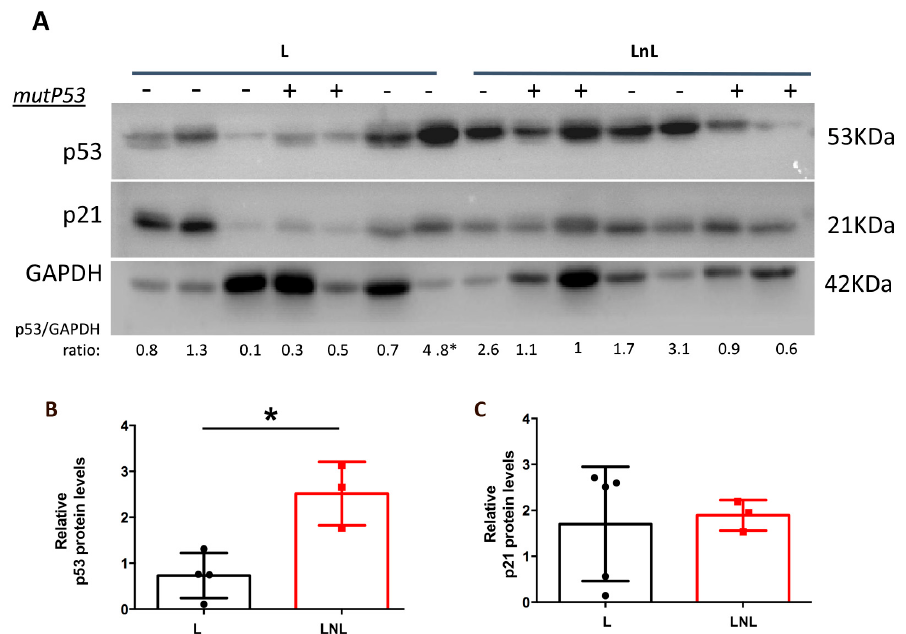
Figure 7. P53 levels are increased in fibrosarcoma of LnL animals. ( A ) WB analysis of indicated protein levels in fibrosarcoma derived from animals of L and LnL groups, GAPDH was used as loading control. Numbers under the lanes report the densitometric value of p53/GAPDH ratio. * marks an outlier value (by ROUT method, Q = 0.1%) not shown in the graph. ( B ) Densitometric analysis of wild type p53 relative to GAPDH levels (mean ± SD) in indicated groups (* p < 0.05, two-tailed unpaired t-test, n = 4 L, 3 LnL). ( C ) Densitometric analysis of p21 (from samples expressing wild type p53) relative to GAPDH levels (mean ± SD) in indicated groups (n.s., two-tailed unpaired t-test, n = 5 L, 3 LnL).